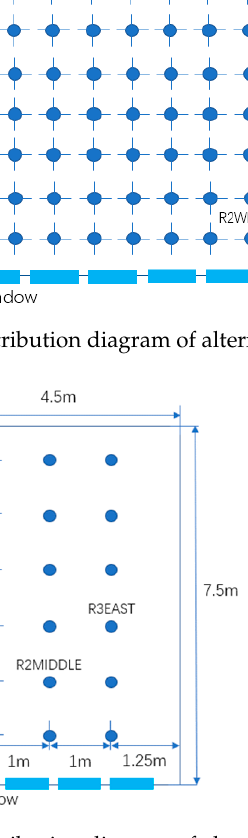
Figure 2. Distribution diagram of alternative sensor locations in the small office space.